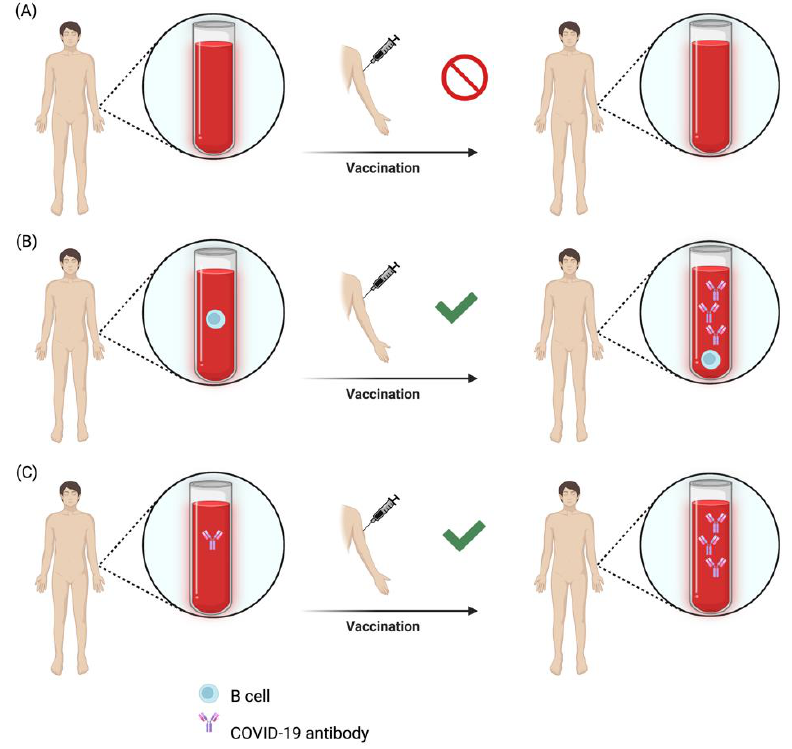
Figure 2. From our findings, three possible scenarios can be deduced to assess the probability of a successful humoral response to COVID-19 vaccination in people under anti-CD20 therapy. ( A ) In a B-cell-depleted person without detectable pathogen-specific antibodies, vaccination likely will not result in seroconversion. ( B ) Once peripheral B-cell repopulation has started, a humoral response to vaccines can be expected. ( C ) In individuals with existing pathogen-specific antibody levels, further antigen contact (recall response) can elicit an adequate antibody production independent of peripheral B-cell recovery. The schematic figure was created with BioRender.com (2022).